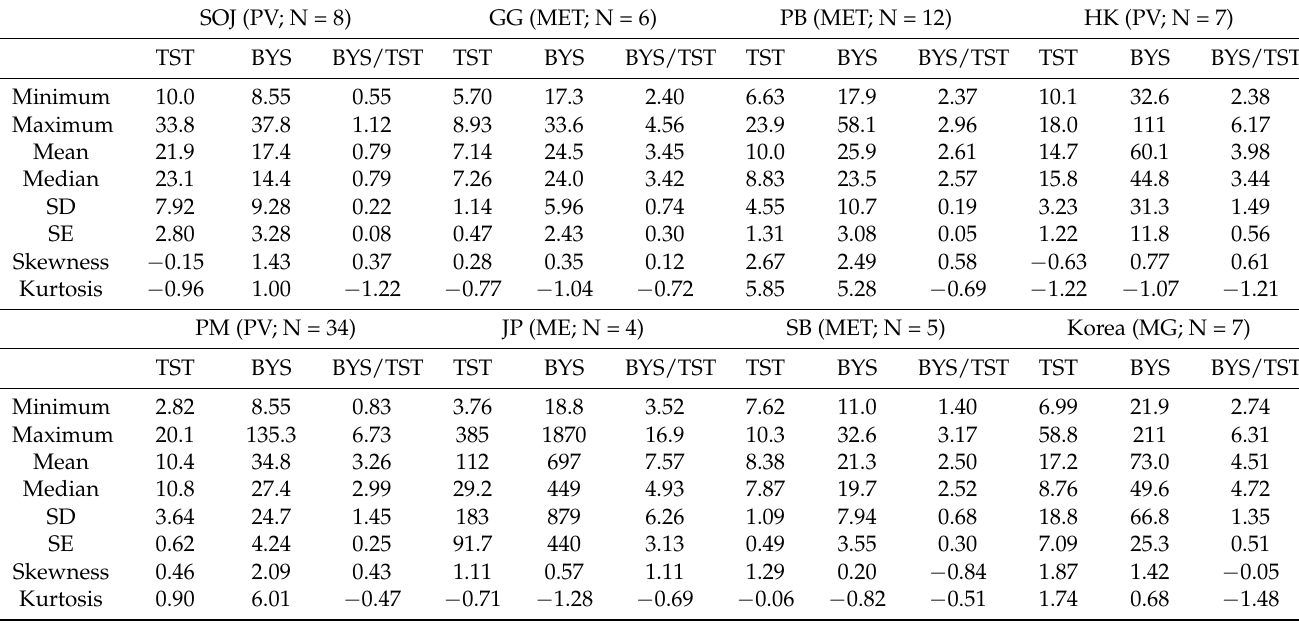
Table 3. Overall statistics of concentrations (mg/kg dry weight) of Cu in the byssus (BYS) and total soft tissues (TST) of Perna viridis and their ratios (BYS/TST), collected from 34 populations in the coastal waters of Peninsular Malaysia (PM) and 2 sites in the Straits of Johore (SOJ) during experiment from the present study, along with those reported in the